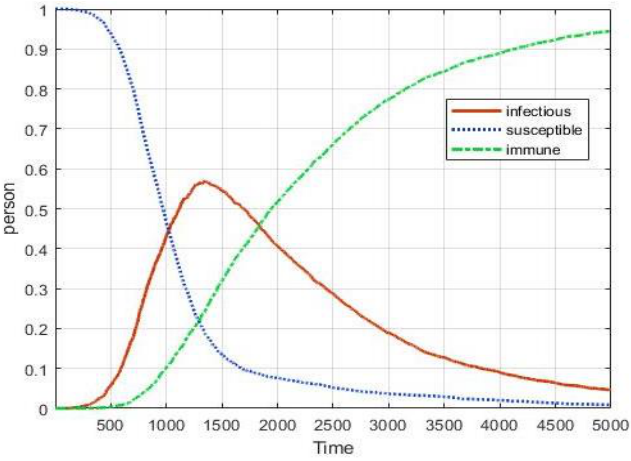
Figure 10. Selective PCR test (peak: 0.57, 1299 ticks). PCR test only for long-term agents.